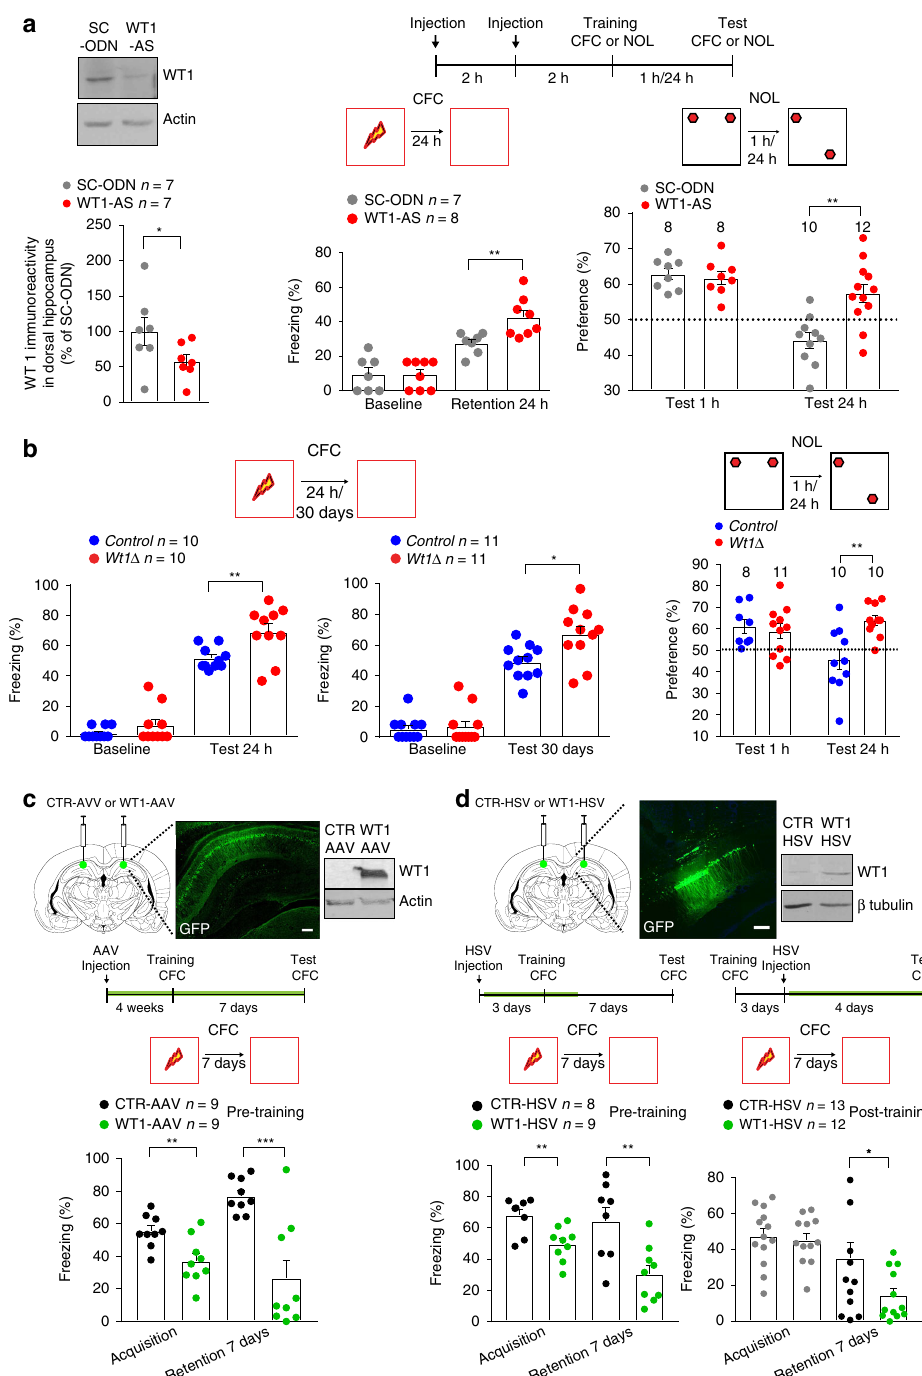
WT1 controls excitability of hippocampal CA1 neurons . Immunohistochemical staining of rat and mouse hippocampus obtained from naïve animals revealed that WT1 is predominantly localized within the nuclei of pyramidal neurons with a weaker immunoreactivity in the proximal apical dendrites. WT1 immu- noreactivity was not detected in astrocytes marked by glial fi brillary associated protein (GFAP-positive) (Fig. 3a –